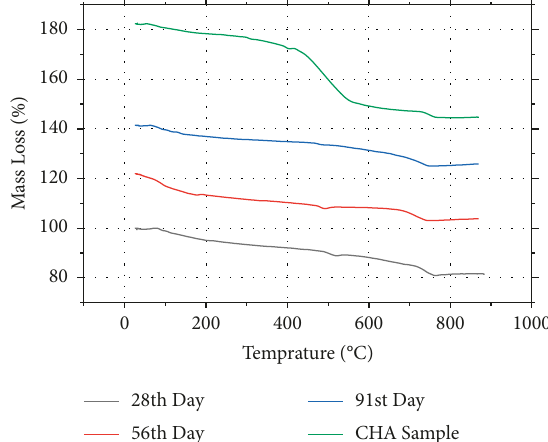
Figure 12: Graphical presentation of TGA for CHA 10% re- placement sample.